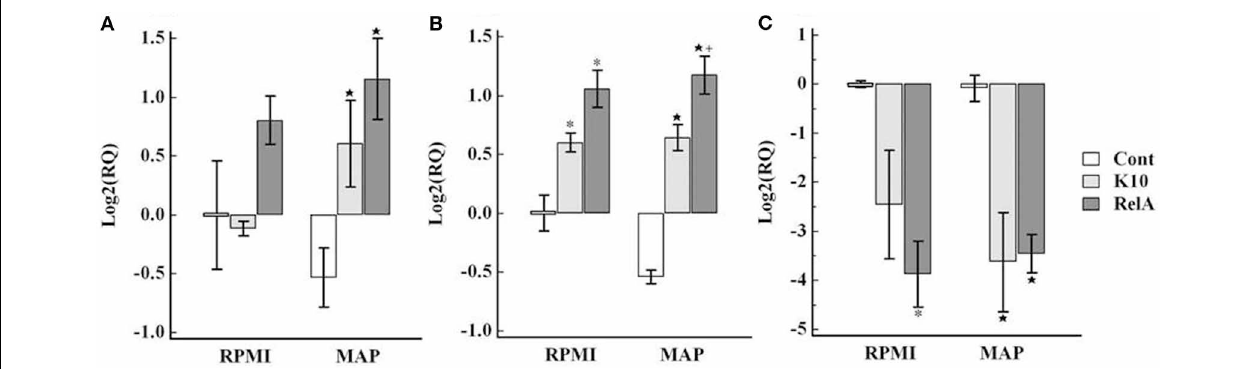
FIGURE 9 | Relative transcription of genes involved in regulating the immune response in PBMC. The relative quantification of mRNA transcription was determined as described in the legend of Figure 7 . The panels show the relative quantification of FoxP3 (A) , TGF- β (B) , IL-10 (C) . RQ,